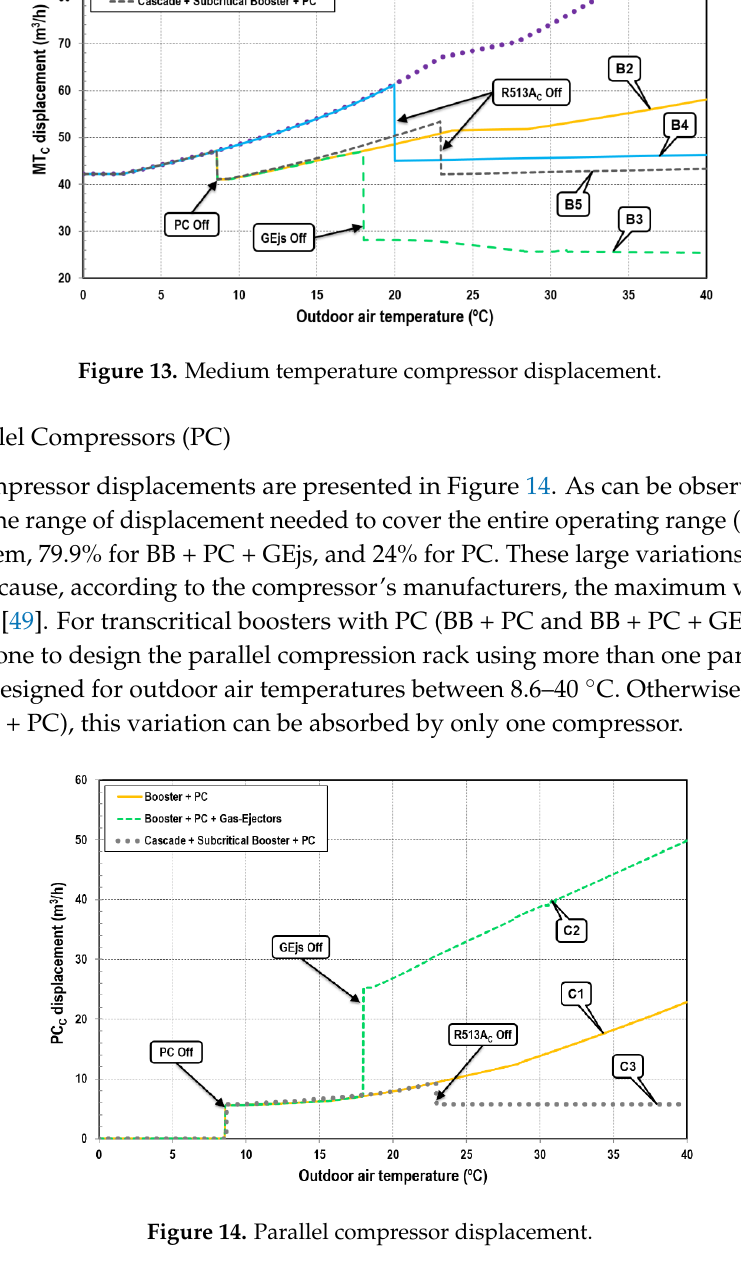
Figure 12. Low temperature compressor displacement.